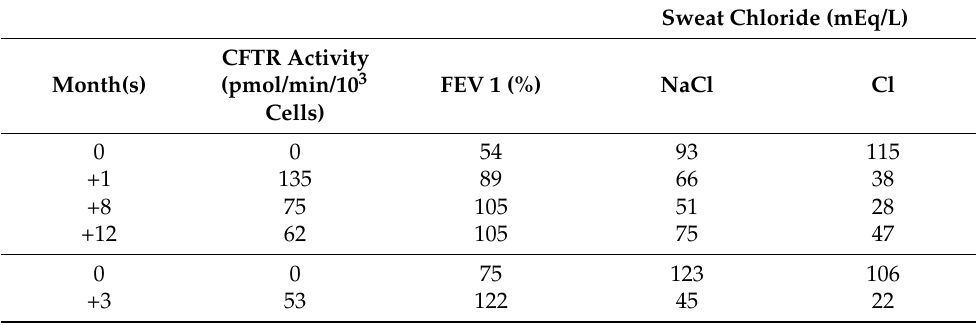
Time indicates the months from the beginning of the Ivacaftor oral therapy. CFTR activity values correspond to those reported in Figure 2A,C, respectively.